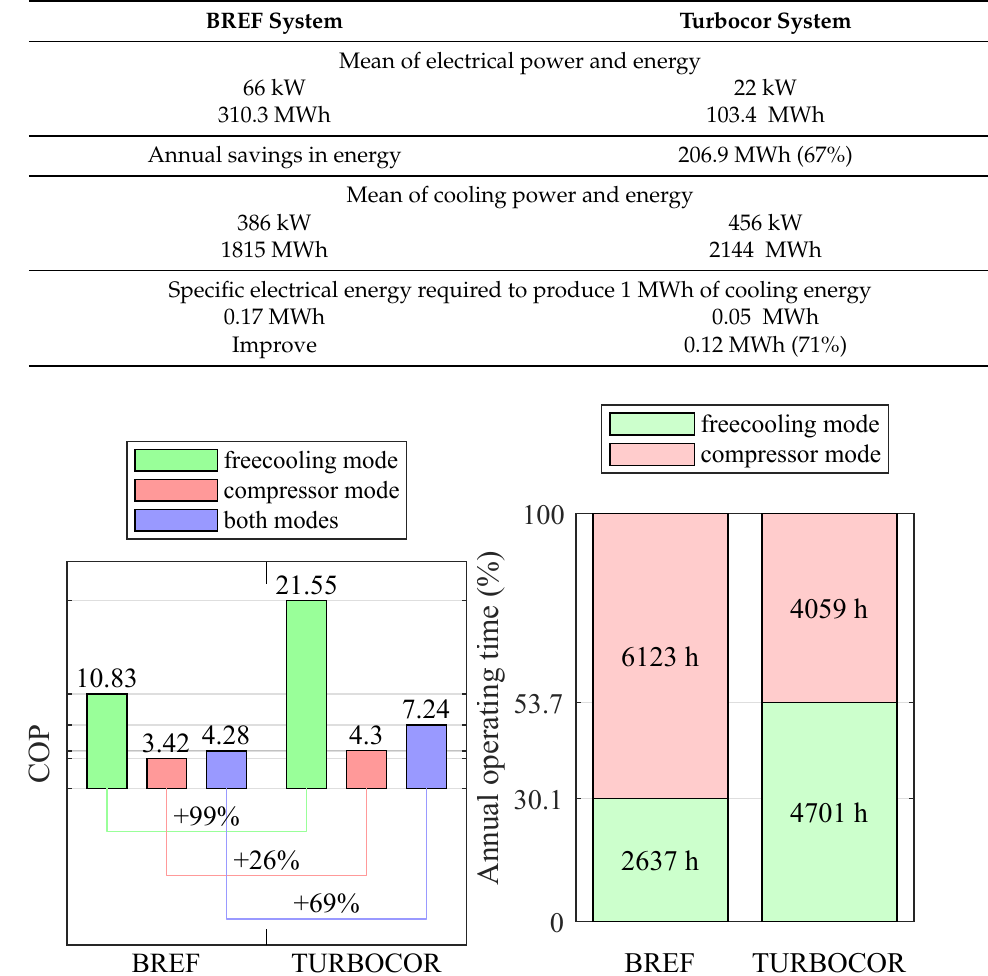
Table 10. System’s power and energy statistic for outdoor temperatures corresponding to Turbocor freecooling operation.